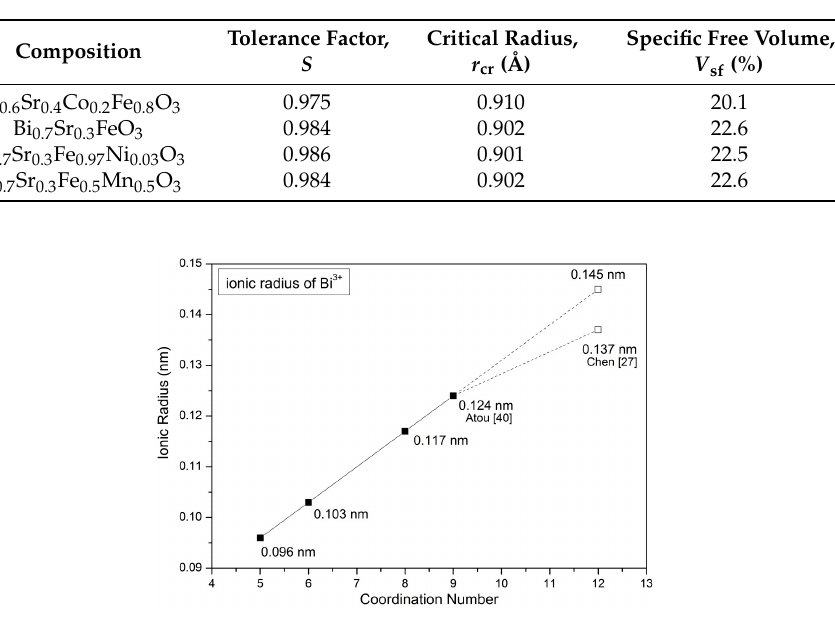
Figure 10. Ionic radius of Bi 3+ with different coordination number (the solid points were obtained from Shannon [39] while the holly-square point is calculated from a linear relationship). Two data points (Atou [40] and Chen [27]) are plotted as well.